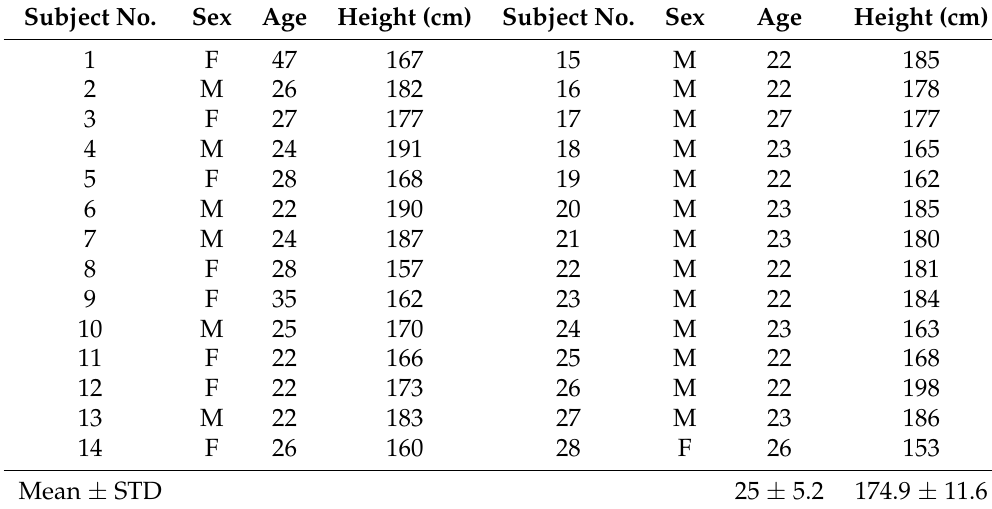
Table 2. Participant details for local